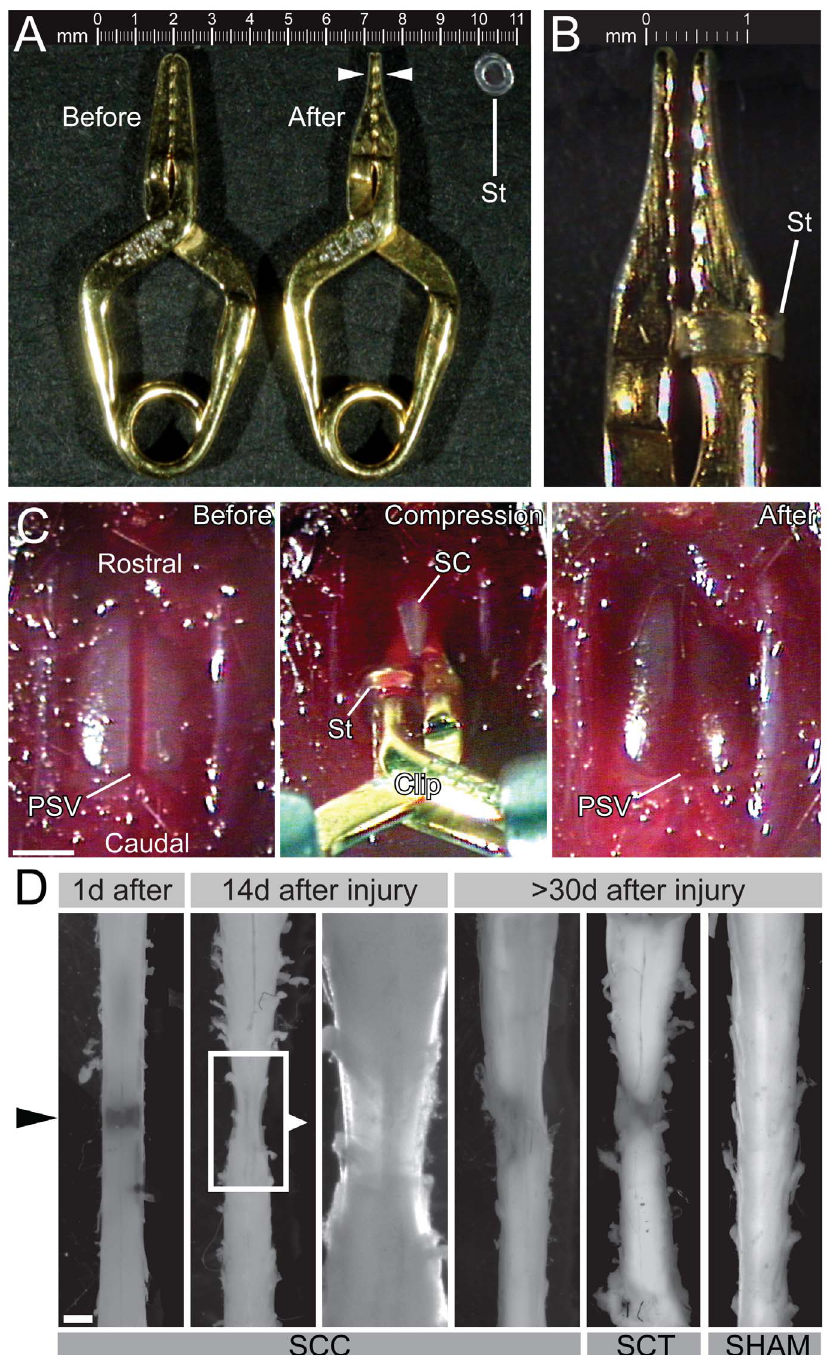
Figure 1. Modifications of the Yasargil aneurysm clip used for SCC, and tissue appearance following SCC. (A) Before (left) and after (right) trimming of the clip blades down to 150 m m. The stopper (St) was fashioned from a slice of polypropylene tubing. (B) When fully released, the clip maintains an interblade distance of 230 m m. (C) Image sequence from surgery showing the laminectomy (‘‘Before’’), the clip-driven compression, and the subsequent hemorrhagic contusion and edema (‘‘After’’). (D) Representative spinal cords dissected at different times after injury. The level of the compression site is indicated by the black arrowhead. The third panel is a high magnification view of the boxed area in the second panel. Scale bars: 1 mm. lateral space to insert the compression clip and an extradural forceps (Fine Science Tools, Heidelberg, Germany). Leaving the spinal cord compression was performed (Fig. 1C). The spinal cord dura intact, parts of the facet joints were removed to gain enough was compressed two times for 15 s each with reversal of the blades